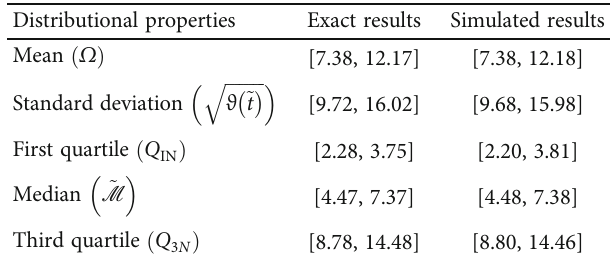
Table 2: Comparisons of the simulated results with analytical results of the